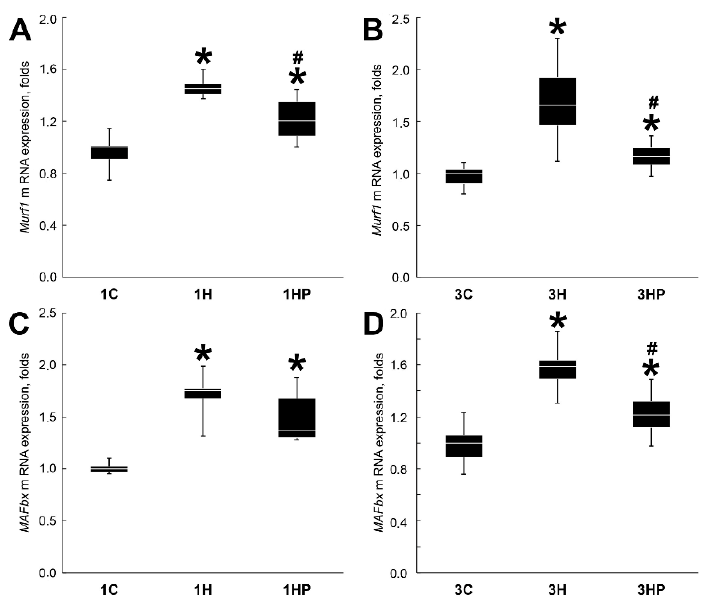
Figure 2. Evaluation of the MuRF1 ( A , B ) and MAFbx ( C , D ) mRNA expression in soleus muscles of non-treated control rats (1C and 3C), rats after 1 and 3 days of unloading (1HS and 3HS), and 1 and 3 days of HS with PRB inhibitor (1HP and 3HP). Levels of MuRF1 and MAFbx mRNA were normalized to the levels of Gapdh in each sample. n = 8. * indicates a significant difference from the control, # indicates a significant difference from the HS group, p < 0.05.